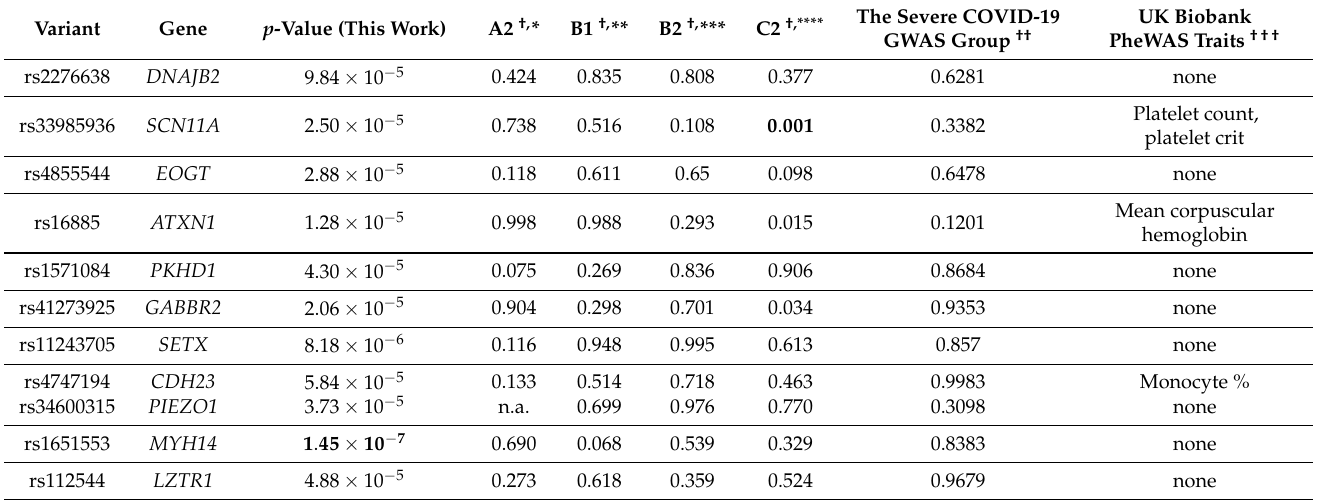
Table 2. Replication of the association for the 11 identified variants in independent